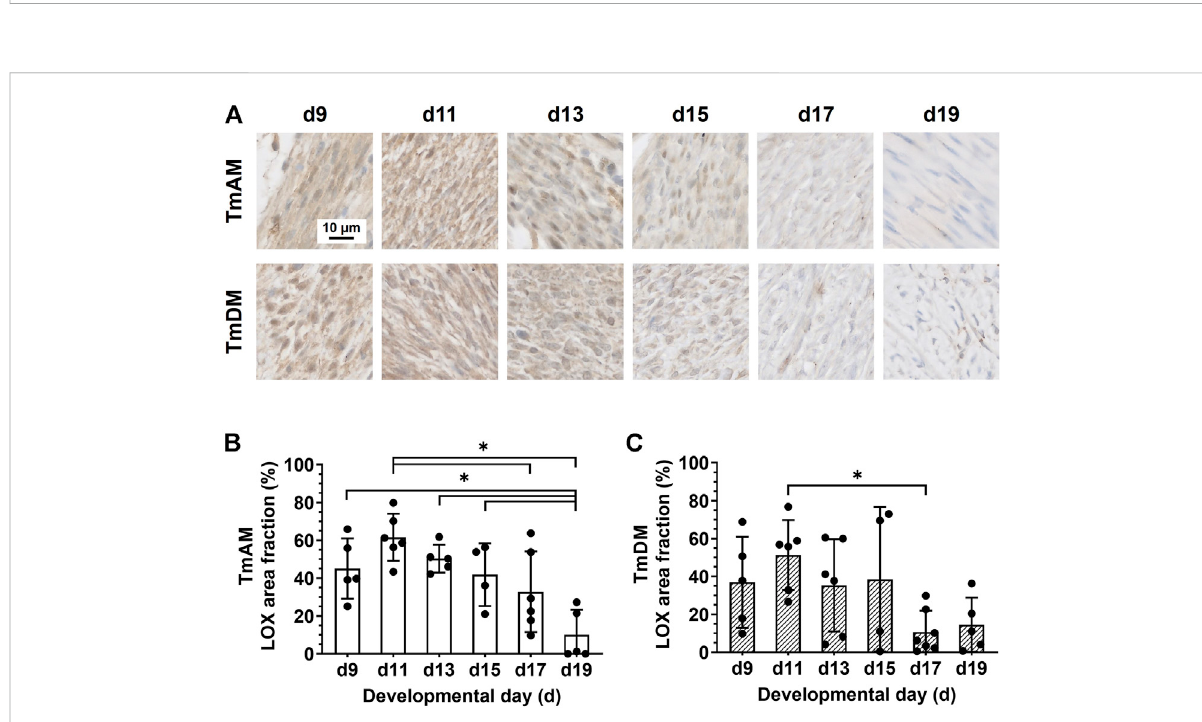
FIGURE 8 LOX decreased during late developmental stages in jaw-closing TmAM and jaw-opening TmDM. (A) Representative bright fi eld images of LOX IHC of TmAM and TmDM. (B) In TmAM, percentage area fraction positive for LOX decreased signi fi cantly from d15 to d19. (C) In TmDM, percentage area fraction positive for LOX decreased signi fi cantly between d11 and d17 in